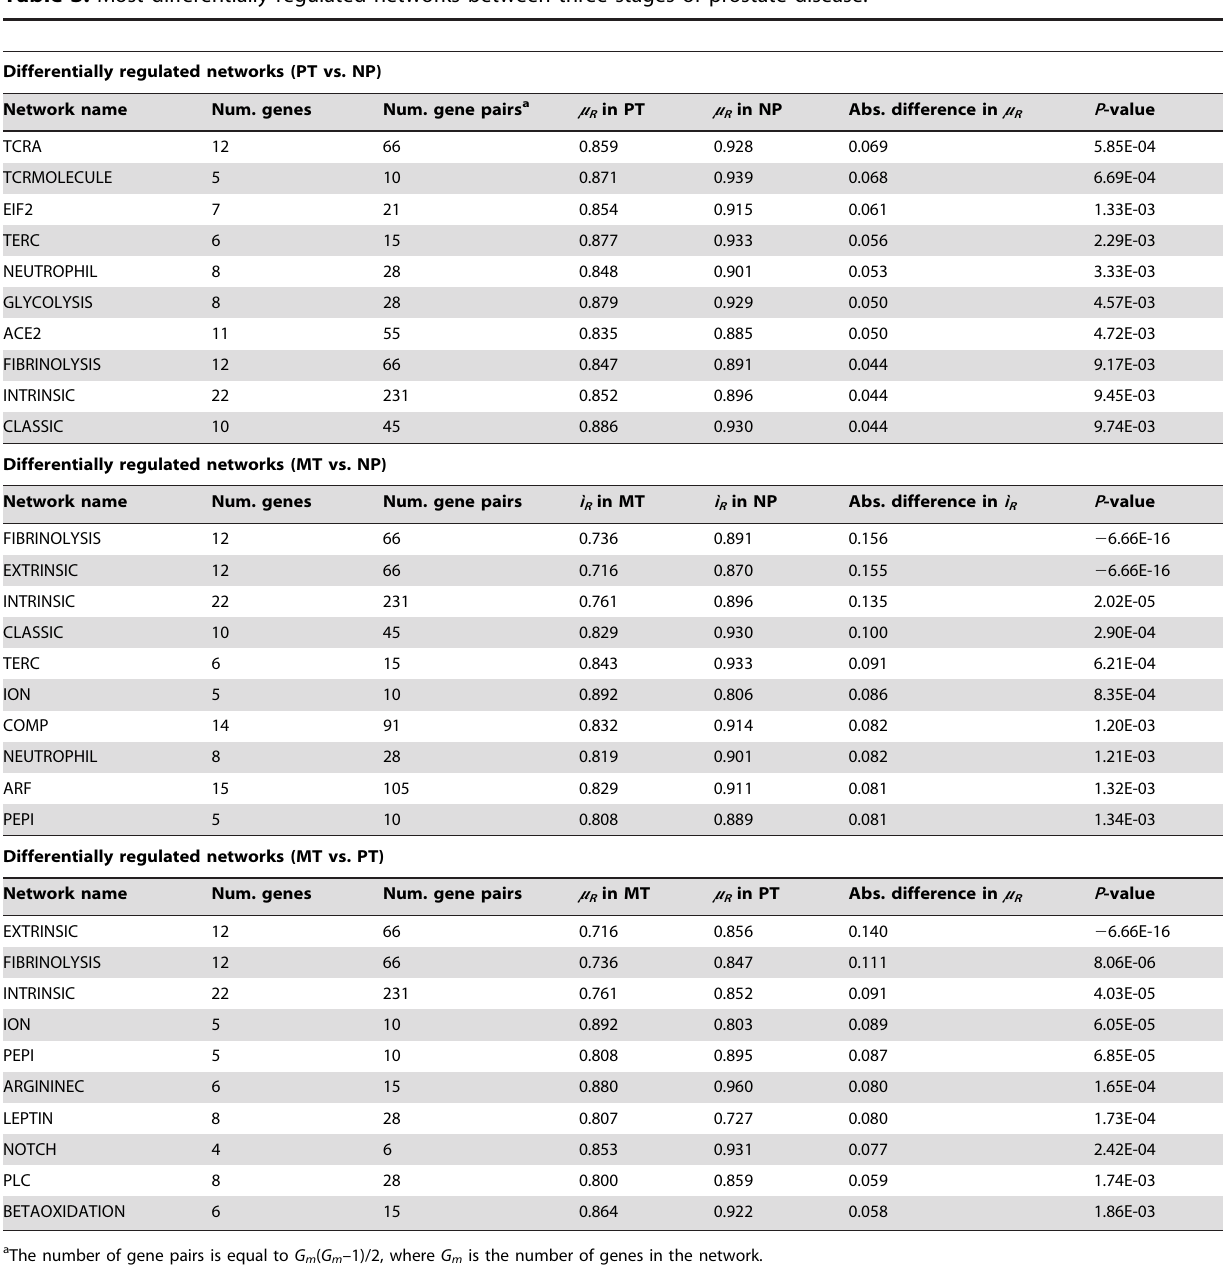
Table 3. Most differentially regulated networks between three stages of prostate disease.